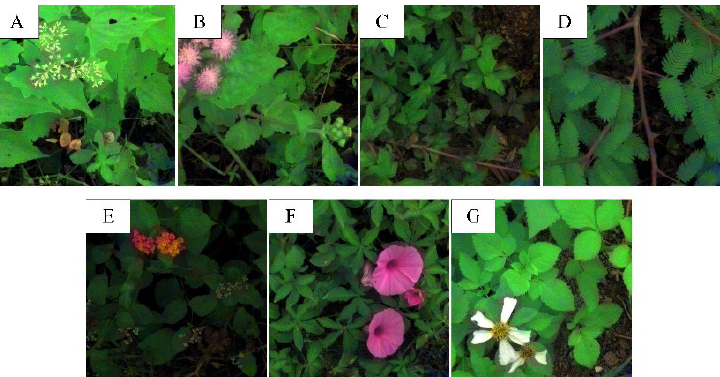
Figure 1. Partial samples of seven invasive plants and the calibration plate. ( A ) Mikania micrantha Kunth, ( B ) Sphagneticola calendulacea (L.) Pruski, ( C ) Ageratum conyzoides L., ( D ) Mimosa pudica Linn., ( E ) Lantana camara L., ( F ) Ipomoea cairica (L.) Sweet, ( G ) Bidens pilosa L..